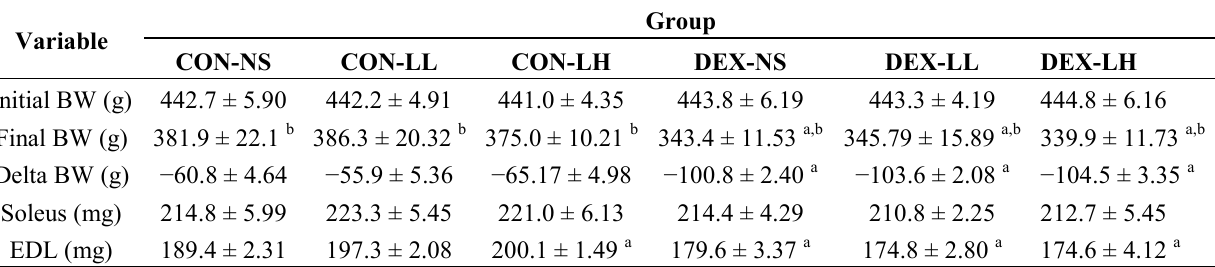
Table 1. Body and muscle morphological parameters of the experimental